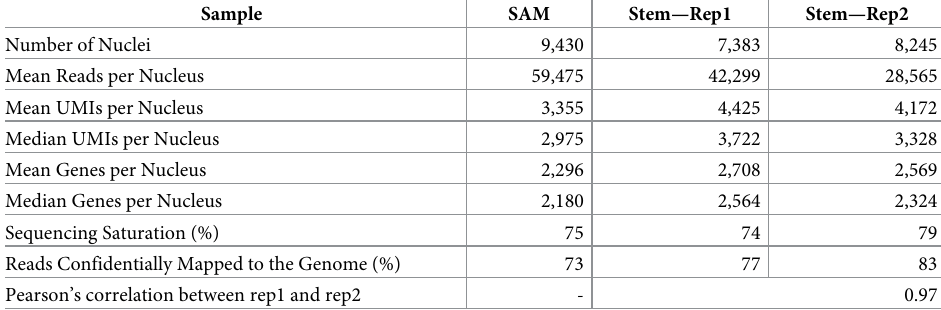
Table 1. Summary of snRNA sequencing and quality control overview for each sample.